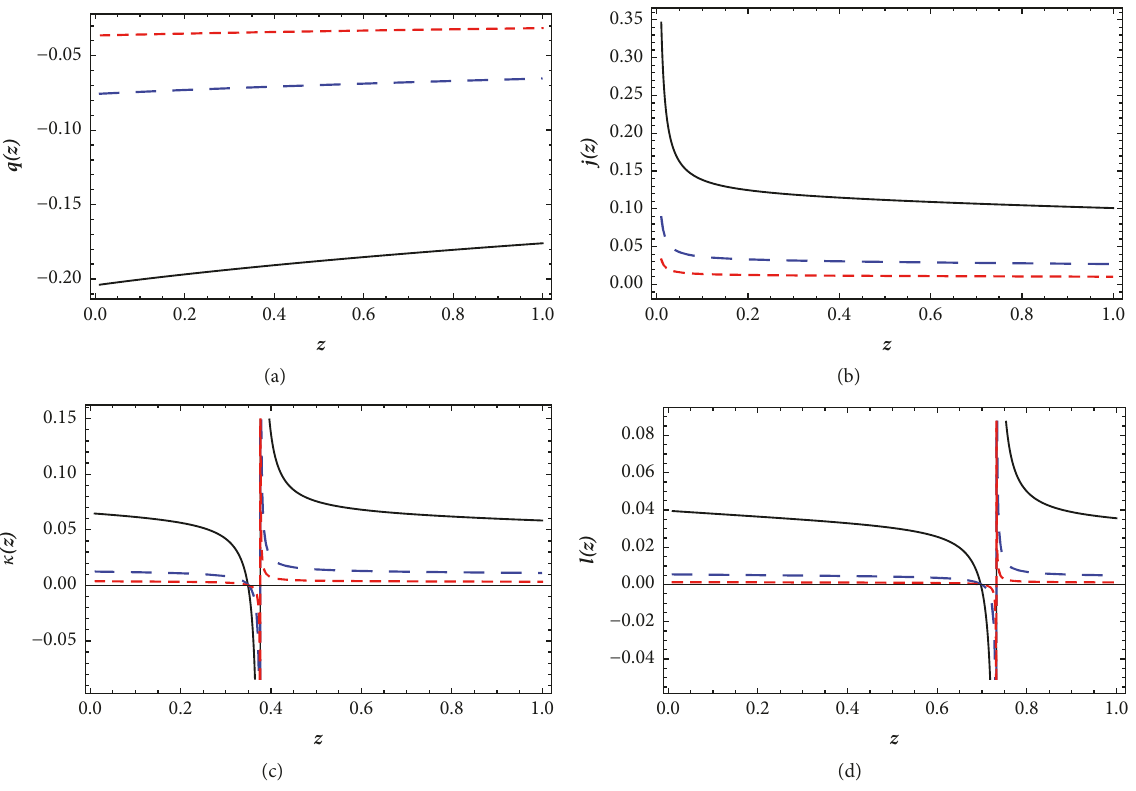
Figure 1: Evolution of (a) deceleration, (b) jerk, and (c) snap parameters (d) as function of red-shift 𝑧 for 𝛼 = 0.8502 and 𝛽 = 0.4817